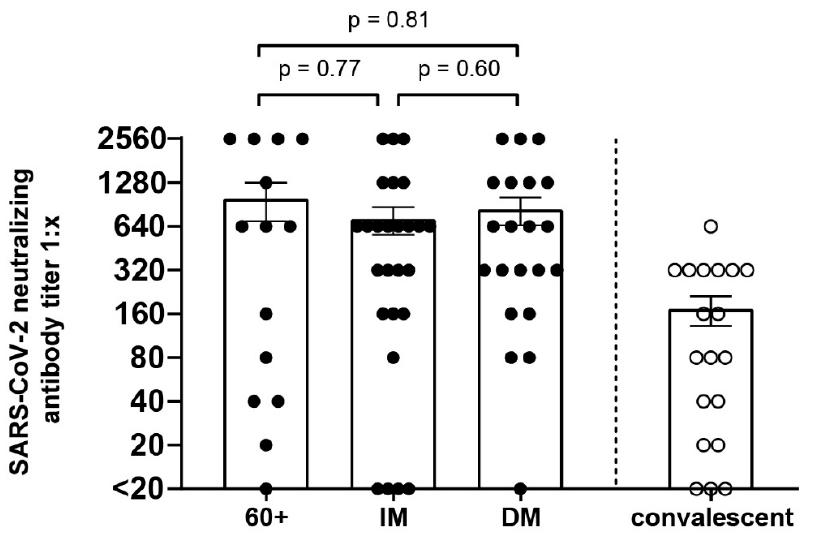
Figure 5. SARS-CoV-2-eutralizing antibody titers of elderly (60+), immunocompromised (IM) and diabetes mellitus (DM) patients compared with a group of convalescents: Virus neutralization assays were performed for 62 patients and 19 convalescent donors. Each dot ( ) represents one patient. (°) represents one convalescent. Comparison between the groups was performed with the Mann–Whitney test. Statistical significance was set at the level of p < 0.05.